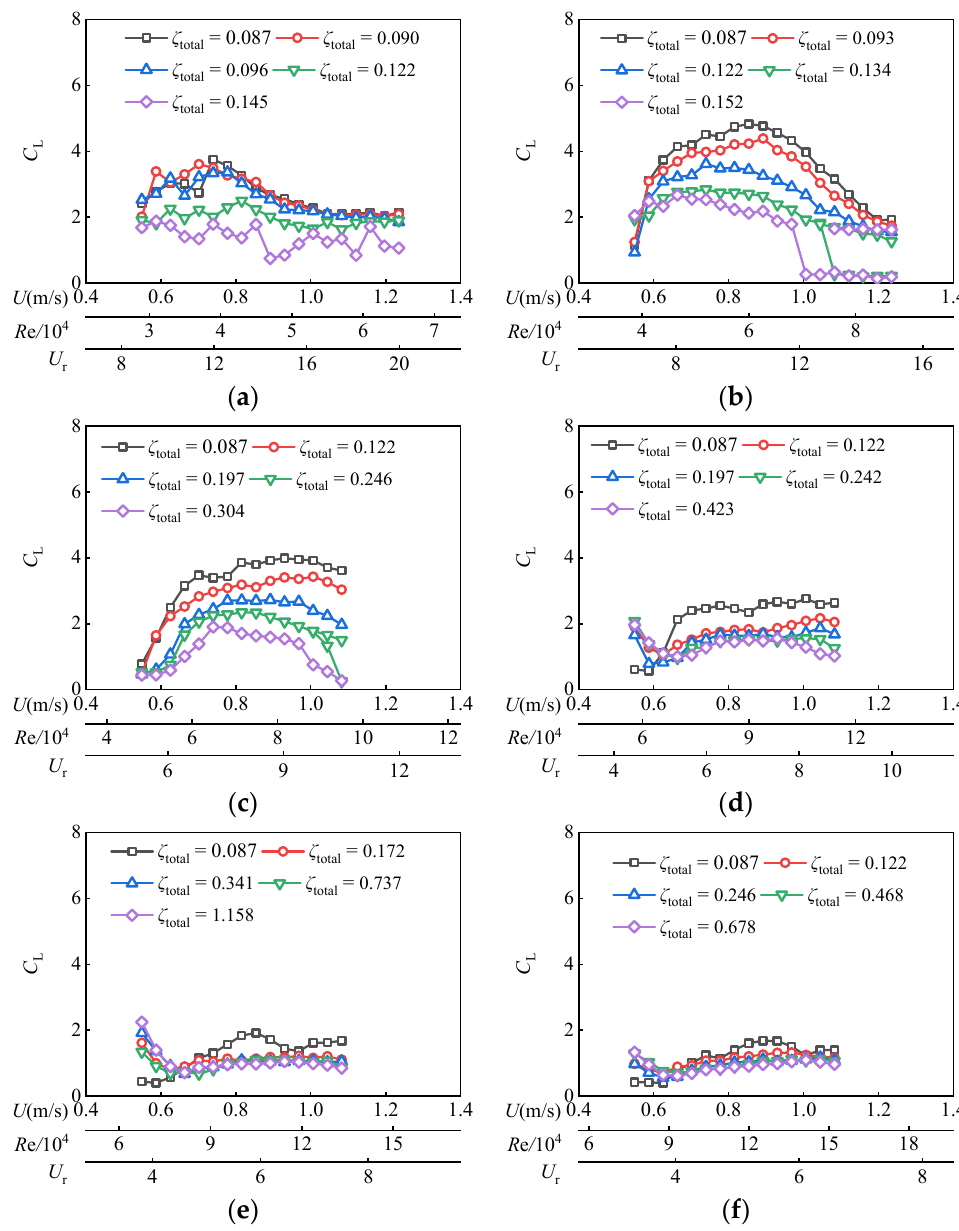
Figure 11. Fluid force of Cir-T-Att. ( a ) D = 0.06 m, Re = 2.89 × 10 4 ~ 6.51 × 10 4 . ( b ) D = 0.08 m, Re = 3.86 × 10 4 ~8.67 × 10 4 . ( c ) D = 0.10 m, Re = 4.82 × 10 4 ~9.48 × 10 5 . ( d ) D = 0.12 m, Re = 5.79 × 10 4 ~1.14 × 10 5 . ( e ) D = 0.14 m, Re = 6.75 × 10 4 ~1.33 × 10 5 . ( f ) D = 0.16 m, 7.71 × 10 4 ~1.52 × 10 5 .